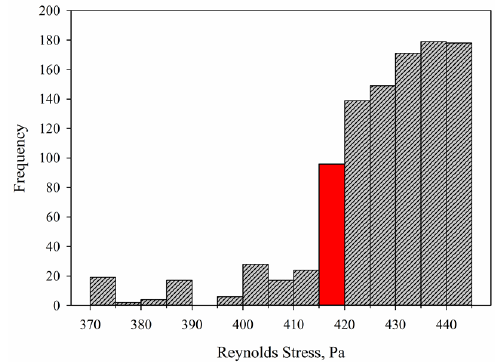
Figure 4. Frequency of Reynolds stresses in Couette viscometer for 450 Pa. The frequency and experimentally observed hemolysis of 85% suggest a threshold of 417 Pa.